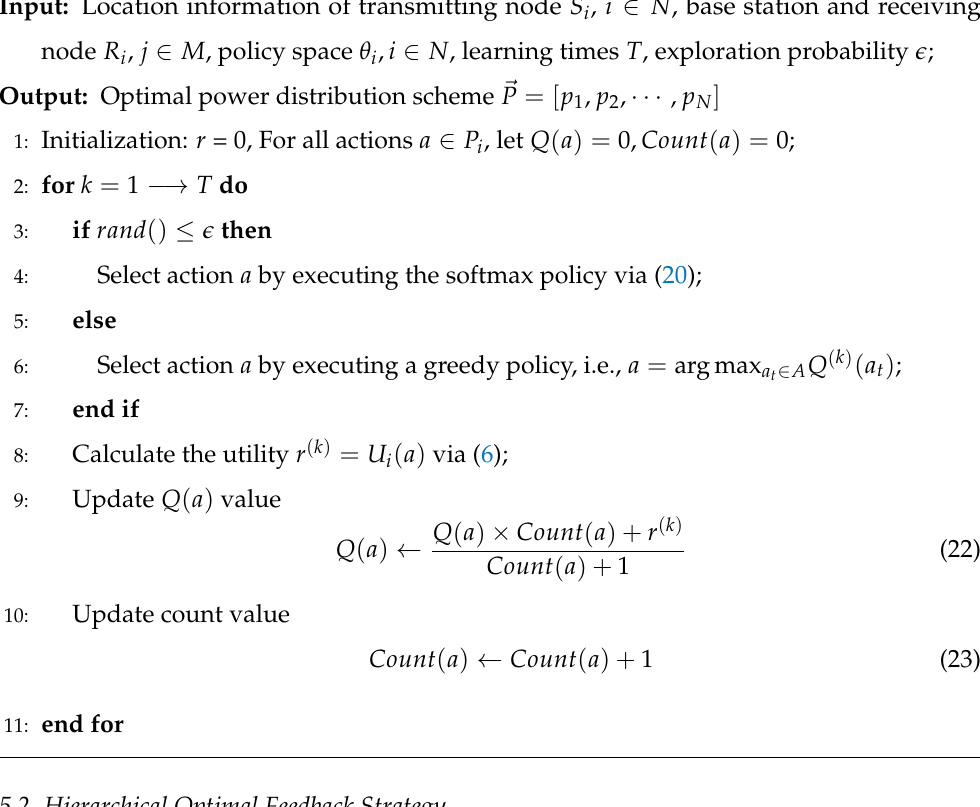
Algorithm 1 Power allocation algorithm based on